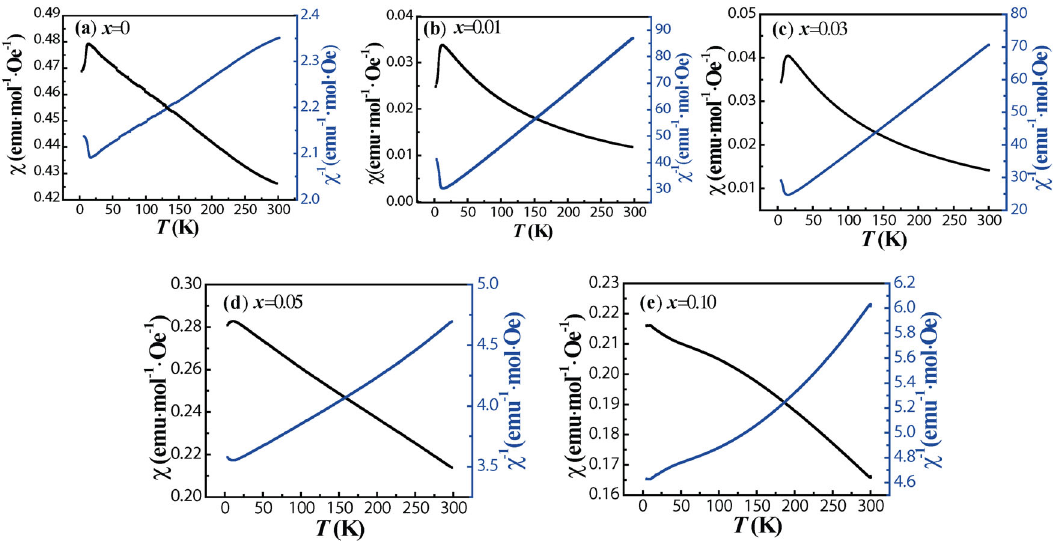
Fig. 9 Temperature dependence of zero-field-cooling susceptibility of the CuFe 1– x Mn x O 2